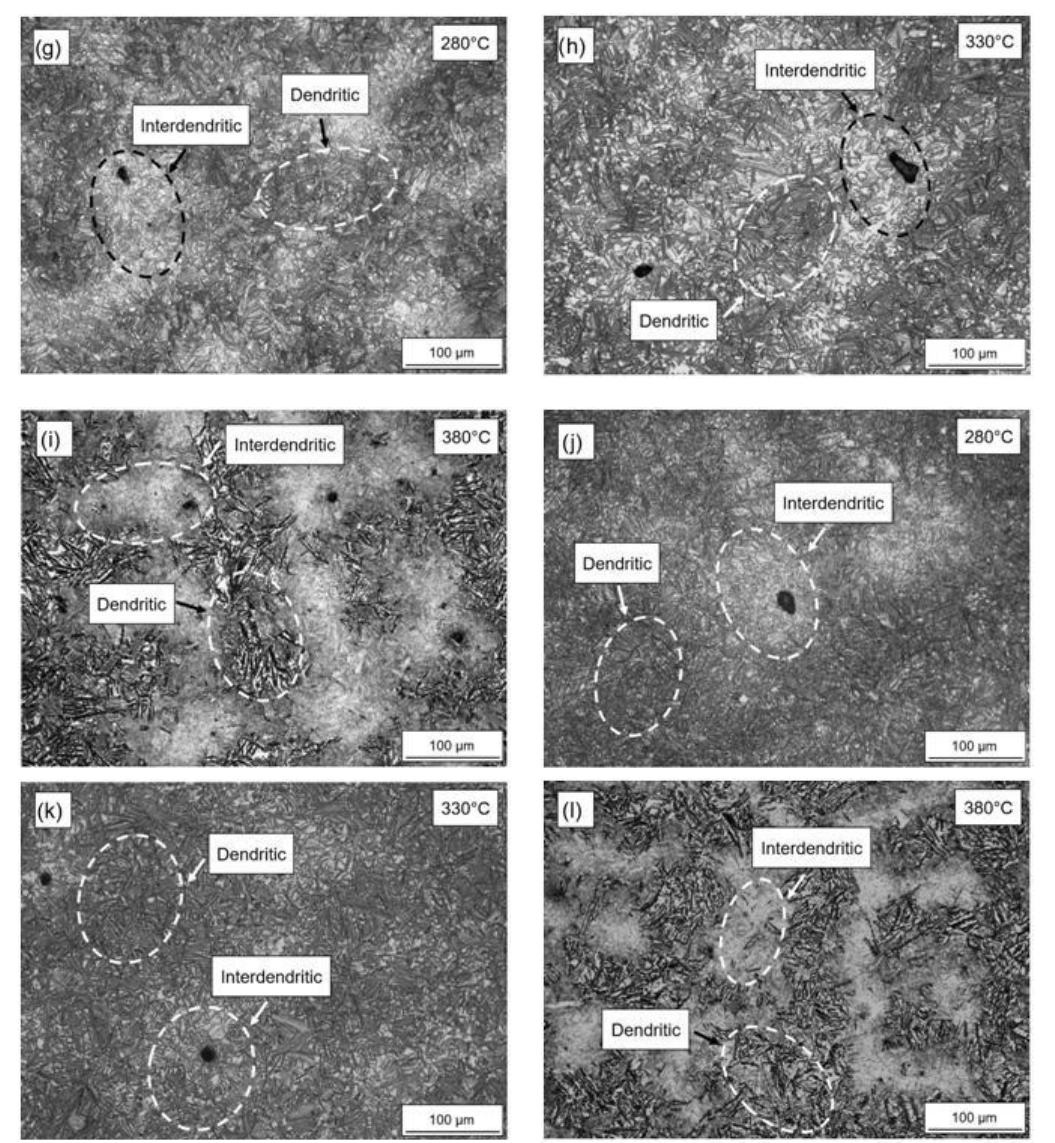
Figure 8. Microstructural evolution as function of isothermal temperature and holding time. ( a – c ): 20 min, ( d – f ): 80 min, ( g – i ): 160 min, ( j – l ): 360 min. Nital 2%.